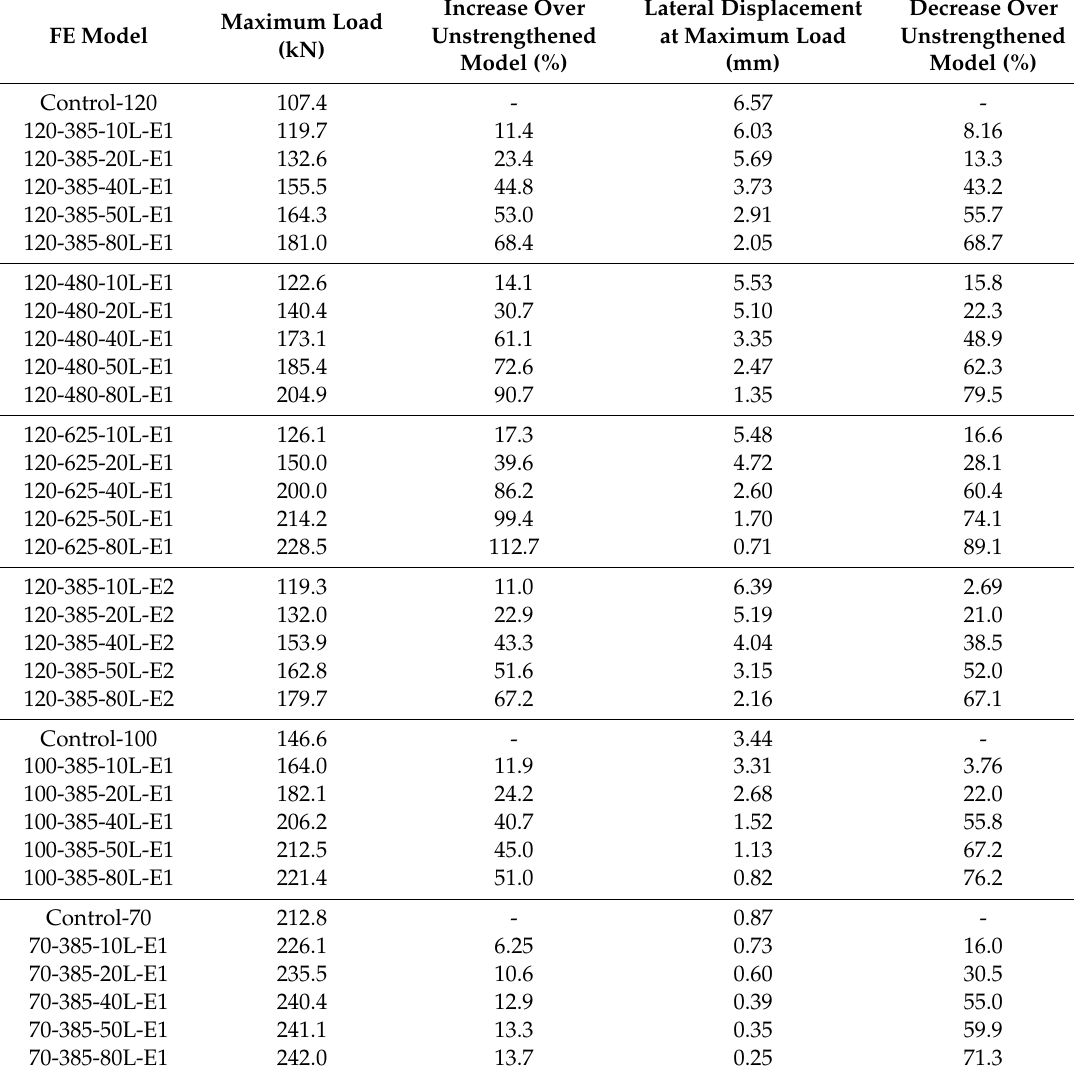
Table 3. Parametric study